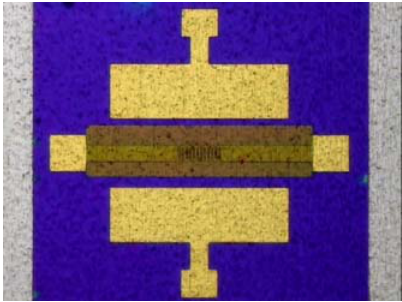
Figure 6. Optical microscopic photograph of micro temperature sensor.